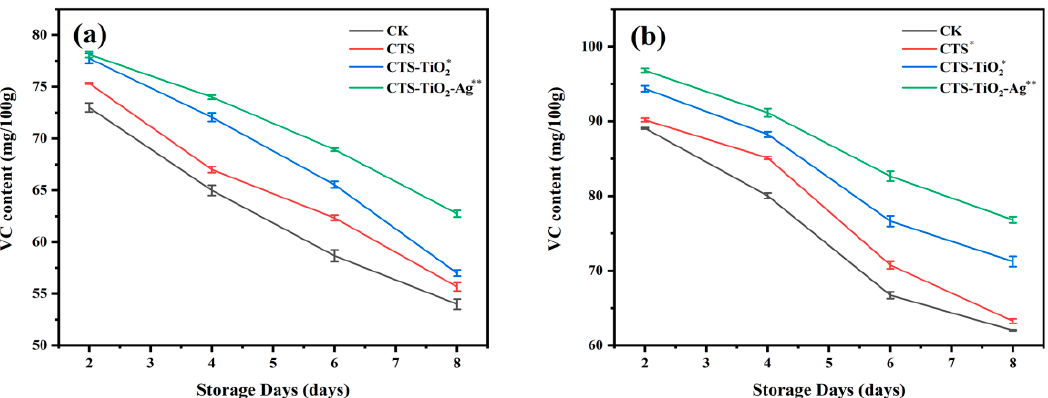
Figure 8. Effect of three different materials on VC content after treatment: ( a ) potato; ( b ) strawberry. CK: Potatoes and strawberries without any treatment; CTS: CTS applied to form film-treated potatoes and strawberries; CTS-TiO 2 : CTS-TiO 2 applied to form film-treated potatoes and strawberries; CTS-TiO 2 -Ag: CTS-TiO 2 -Ag applied to form film-treated potatoes and strawberries. Data given demonstrate the average of at least three replications (n = 3) ± SD. Asterisks within rows indicate significant differences (* p < 0.05, ** p < 0.01, *** p < 0.001), according to Student’s t -test.